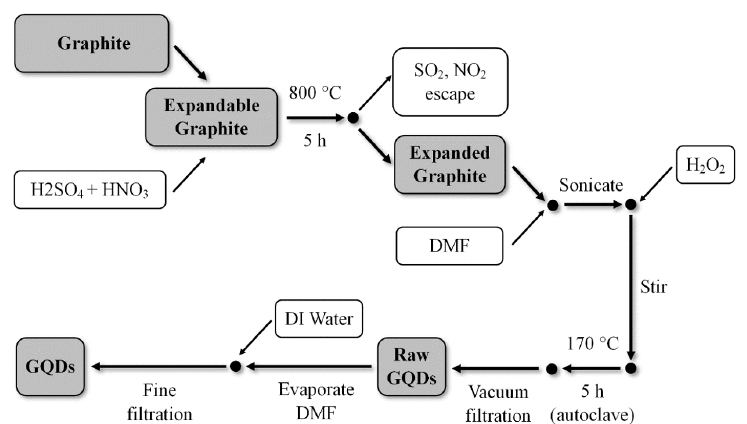
Figure 7: Flowchart of the solvothermal synthesis of graphene quantum dots from graphite using hydrogen peroxide as the oxidant (Tian et al ., 2016; Bandara et al ., 2022a).